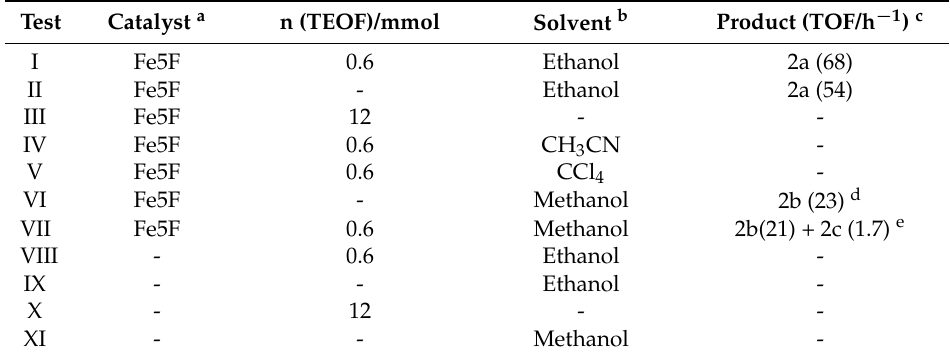
Table 3. Reaction conditions and TOF values for product formation in different tests to evaluate the role of TEOF in benzaldehyde acetalization at 60 ◦